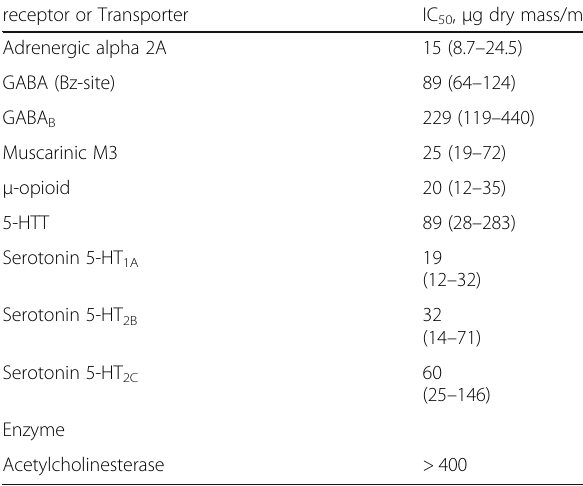
Data table to Fig. 1 supplemented by competition binding of Salvia officinalis extract at the GABA A (Bz-site) receptor, the GABA B receptor, the human serotonin 5-HT 2B receptor expressed in CHO-K1 cells, and inhibition of acetylcholinesterase. Data are IC 50 values and 95% confidence intervals of summary curves over 2 – 3 independent experiments performed in